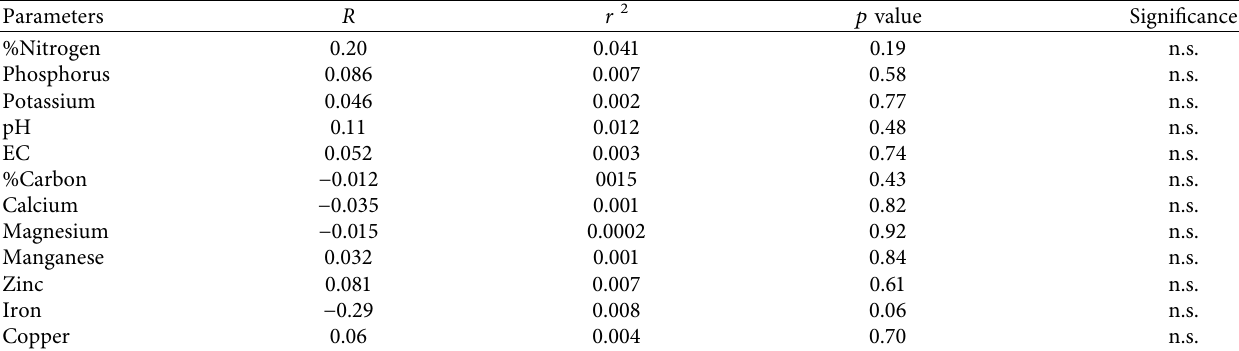
Table 3: Infuence of soil nutrients on oil yield presented as the correlation coefcient R and the coefcient of determination resulting from Pearson